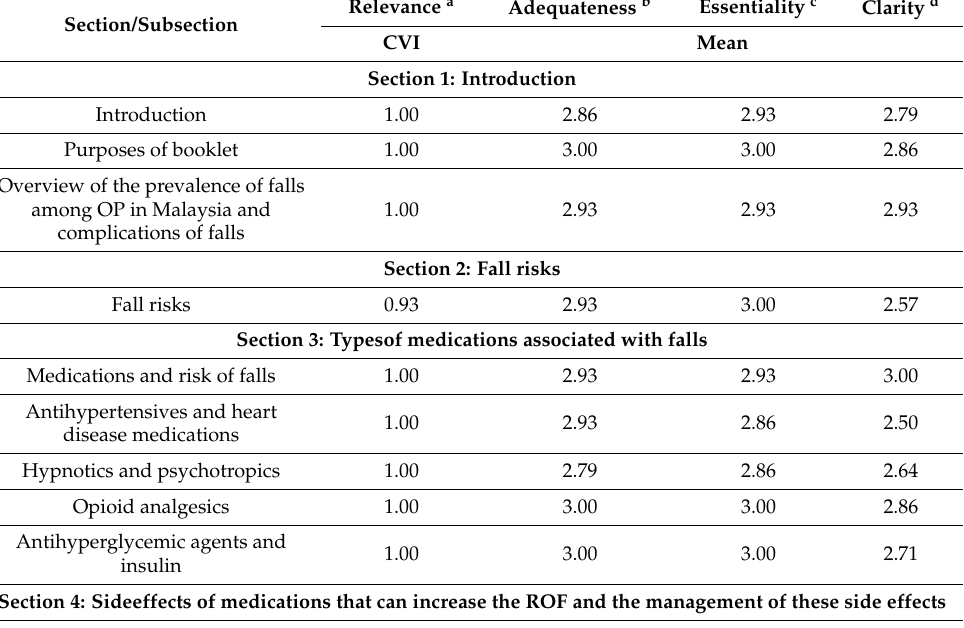
Table 2. Relevance, adequateness, essentiality, and clarity of the content of each subsection of the booklet.